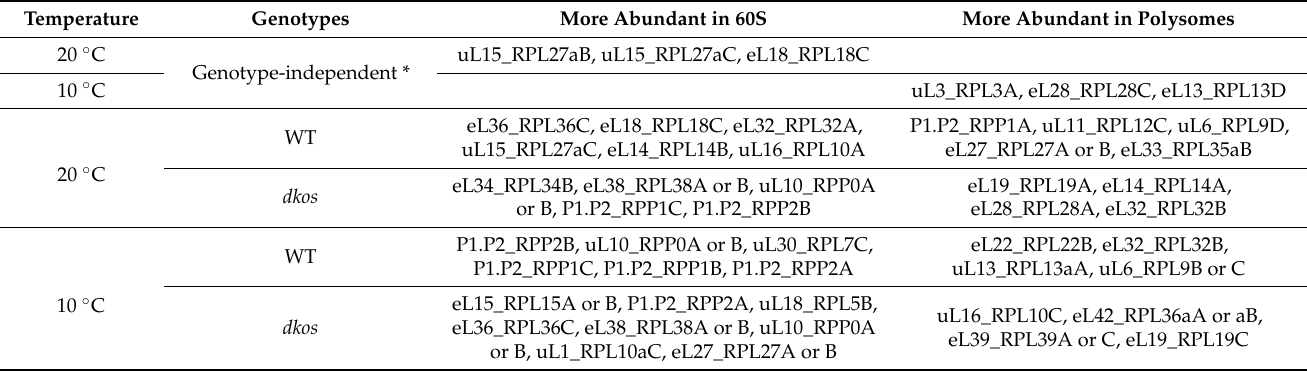
Figure 4. Substoichiometry of 60S proteome LSU-RPs 7 days after shifting from 20 °C to 10 °C in Arabidopsis thaliana Col-0 roots (left panel) and at the same time point in two double knockouts ( dkos ) genotypes of REIL proteins (right panel). Normalized protein abundances (Table S3) were used to calculate Ln-transformed ratios between the 60S and the polysome fraction. Only RPs that appeared in all replicates across the ratio components were considered. Ratios were genotype and temperature-specific (Table S4). The resulting RP paralog ratios were divided into four groups: dark-purple, high increase or higher abundance of one or more RP paralogs in polysomes (Ln-ratios < 2.0 and > 1.0); purple, increase or more abundance (Ln-ratios > 0.0 and ≤ 1.0); yellow, decrease or less abundance (Ln-ratios ≥ −1.0 and < 0.0); off-white, no change. The 60S-RP ratios that belonged to the highest and lowest ten magnitudes were colored into a 3D rendering of the 60S subunit. * Black asterisks indicate RP families with significant substoichiometric paralogs (GLM — p Values > 0.01 ^ < 0.05 = **; > 0.05 ^ < 0.1 = *) in polysomic compared to the 60S fractions with a single regressor, namely temperature as the sole experimental factor ( n = 4; dko 1, dko 2, WT-DS1, WT-DS2). Only one significant change does not coincide with the largest fold changes and hence is not visualized (i.e., eL8_RPL7aB — see Table S3). Table 1. Paralogs of RP families that showed altered stoichiometry in 60S and polysome